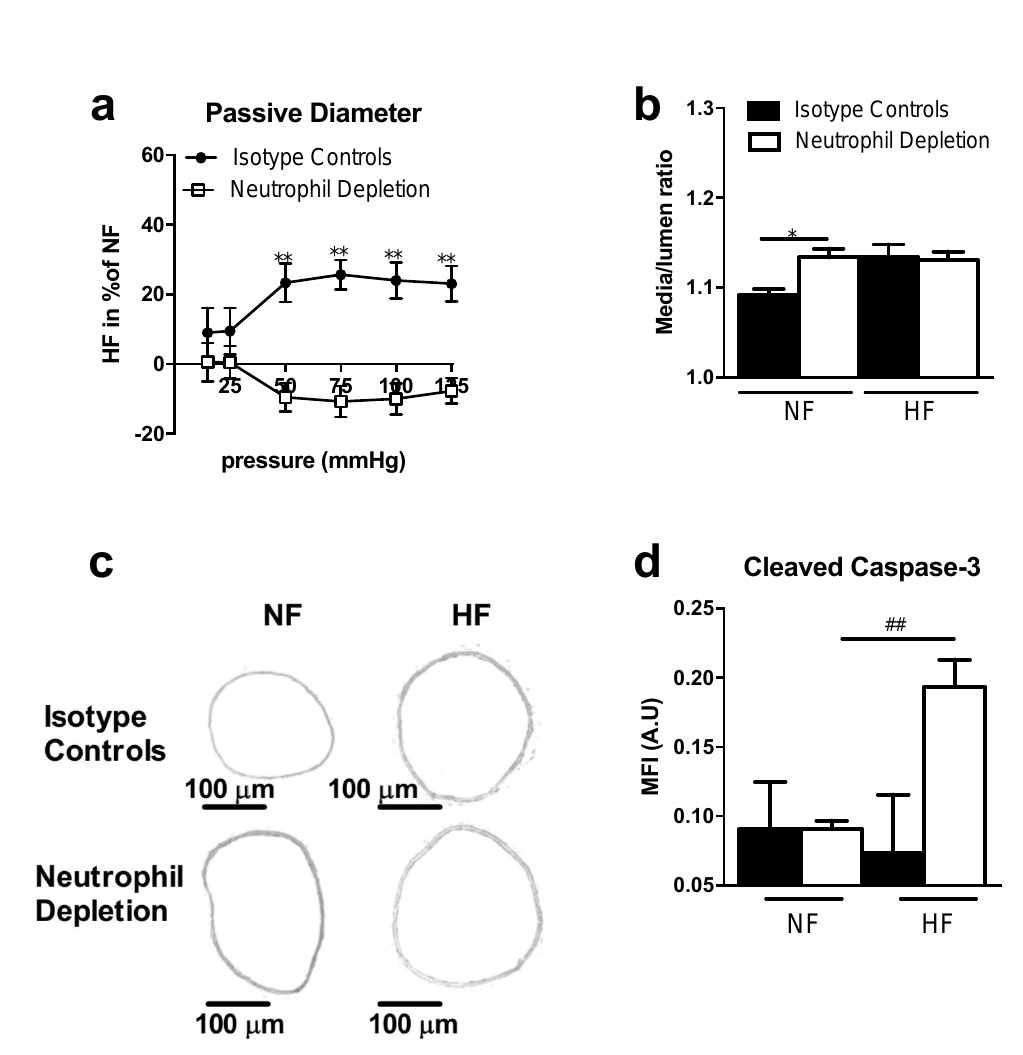
Figure 5. Remodeling study after seven days of chronic increase in blood flow and neutrophils depletion. Graphs show